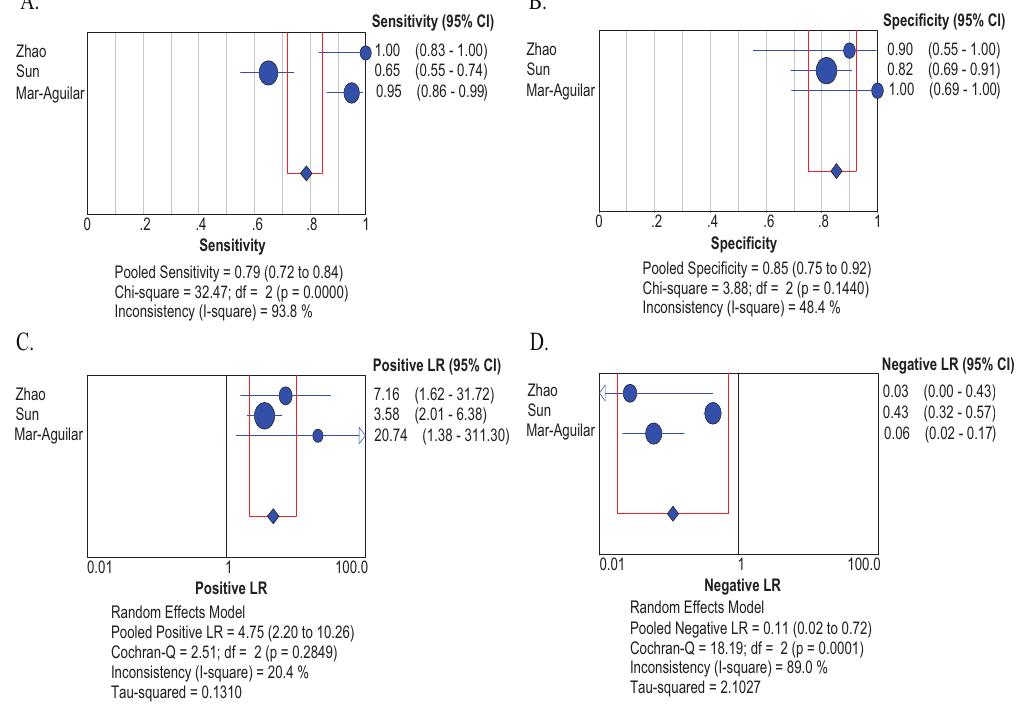
Figure 2. The pooled diagnostic indices for the diagnosis of BC through circulating miR-155. ( A ) The pooled sensitivity for the diagnosis of BC through circulating miR-155; ( B ) the pooled specificity for the diagnosis of BC through circulating miR-155; ( C ) the pooled positive likelihood for the diagnosis of BC through circulating miR-155; ( D ), the pooled negative likelihood ratio for the diagnosis of BC through circulating miR-155.